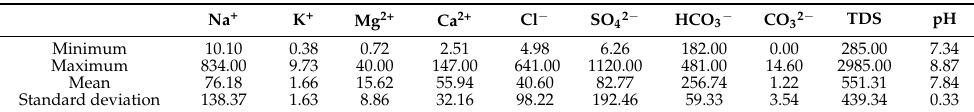
Table 1. Statistics of the hydrochemical parameters of the groundwater in the study area during the rainy season (unit: